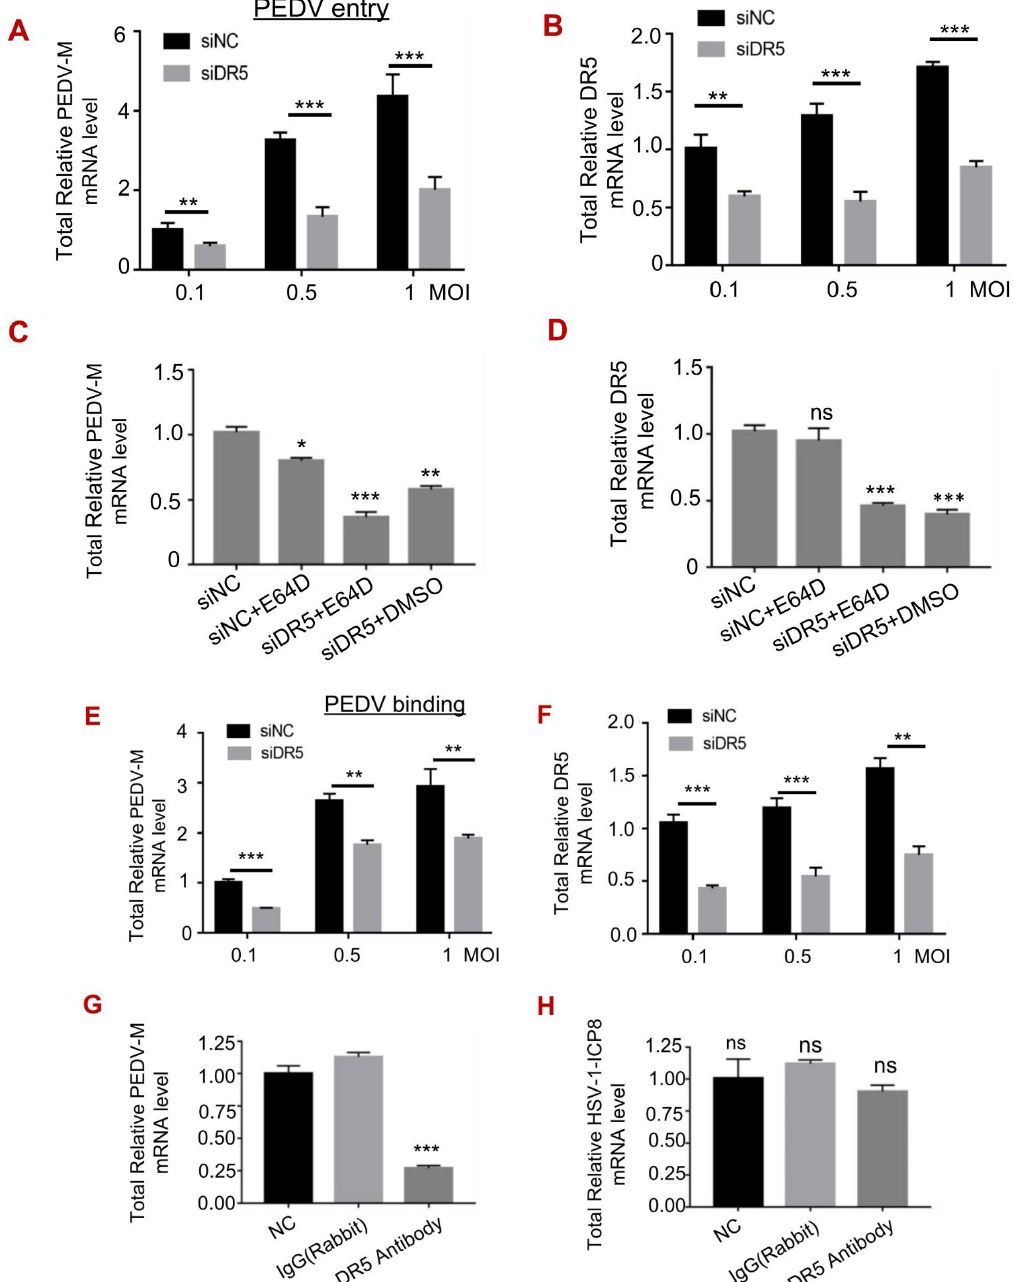
Figure 4. DR5 facilitates viral entry of PEDV into Vero cells. ( A , B ), Vero cells were transfected with siDR5 or siNC for 36 h, and infected with PEDV at an MOI of 0.1, 0.5, or 1 at 37 ◦ C for 2 h. After washing with PBS, the infected cells were harvested. The mRNA levels of PEDV m ( A ) and DR5 ( B ) were subjected to RT-qPCR analysis. C-D, Vero cells were transfected with siDR5 or siNC for 36 h, and were pre-treated with E64D (0.1 µ M) for 1 h before viral infection. Cells were then infected with 1 MOI PEDV at 37 ◦ C for 2 h and the mRNA levels of PEDV m ( C ) and DR5 ( D ) were subjected to RT-qPCR analysis. ( E , F ), Vero cells were transfected with siDR5 or siNC for 36 h, and then infected with PEDV at an MOI of 0.1, 0.5, or 1 at 4 ◦ C for 1 h. The mRNA levels of PEDV m ( E ) and DR5 ( ◦ C) were subjected to RT-qPCR analysis. G-H, Vero cells were pre-treated with rabbit antibody against DR5 (1:100) or rabbit IgG (1:100) for 2 h. After washing with PBS, cells were infected with 1 MOI PEDV or HSV-1 at 4 ◦ C for 1 h. The mRNA levels of PEDV m ( G ) and HSV-1-ICP8 ( H ) were subjected to RT-qPCR analysis. *, p < 0.05; **, p < 0.01; ***, p < 0.001; ns p >